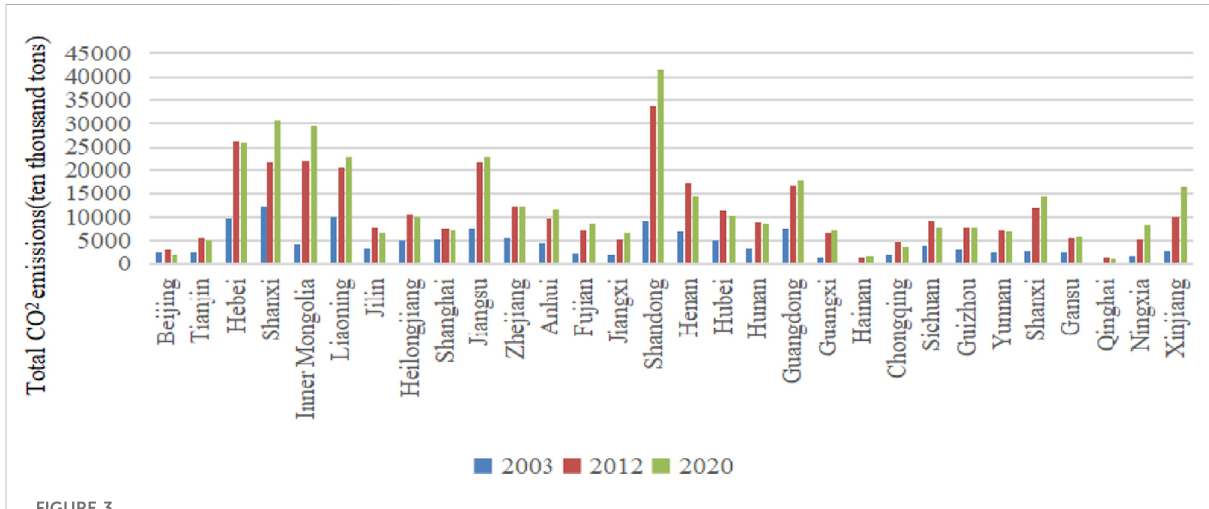
FIGURE 3 Three-year carbon emissions of 30 provincial-level regions in China.